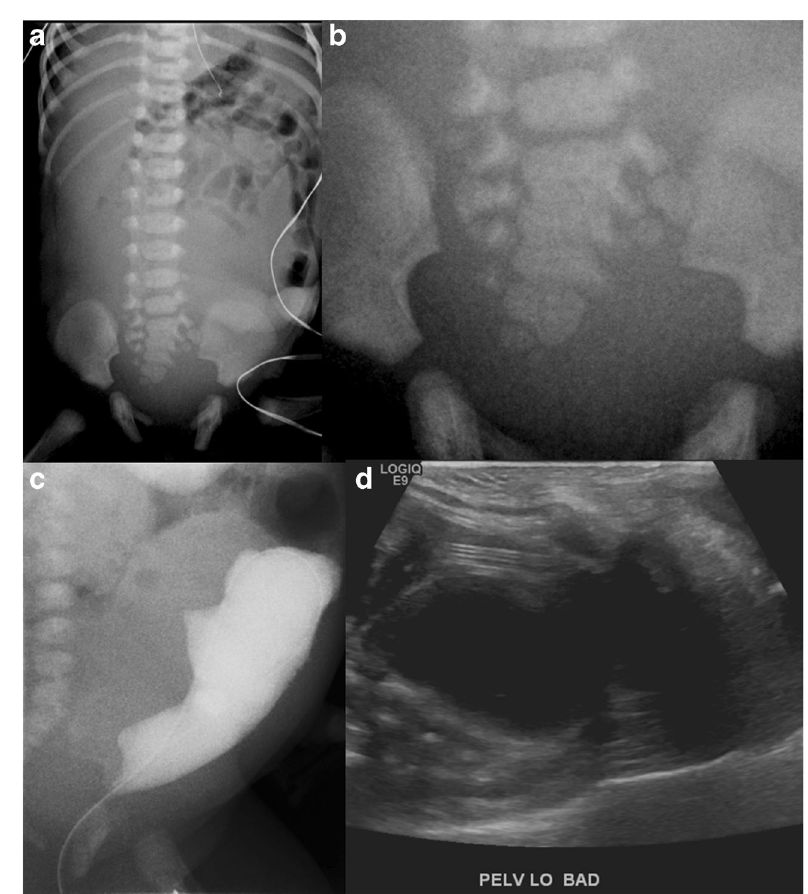
Fig. 5 a - d : Dysmorphic sacrum with imperforate anus and presacral cystic mass: Frontal abdominal radiograph of a newborn demonstrates absence of bowel gas in the pelvis ( a ) with a history of no passage of meconium; the patient had ano- rectal atresia. Pelvic radiograph ( b ) demonstrates an abnormal sa- crum. Retrograde cystogram ( c ) demonstrates an elongated uri- nary bladder with extrinsic in- dentations along its posterior as- pect, suggesting a pelvic mass. Pelvic ultrasound ( d ) demon- strates a lobulated cystic pelvic mass; pathology was consistent with